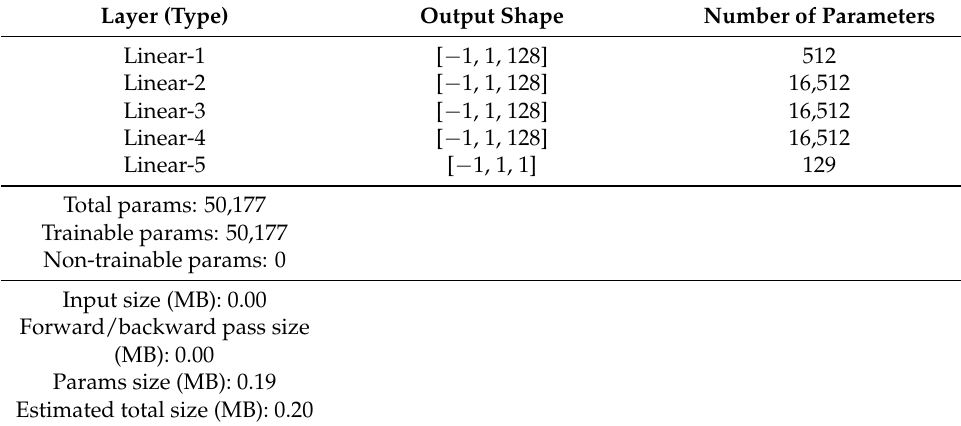
Table 3. The estimation of SIREN network size with four